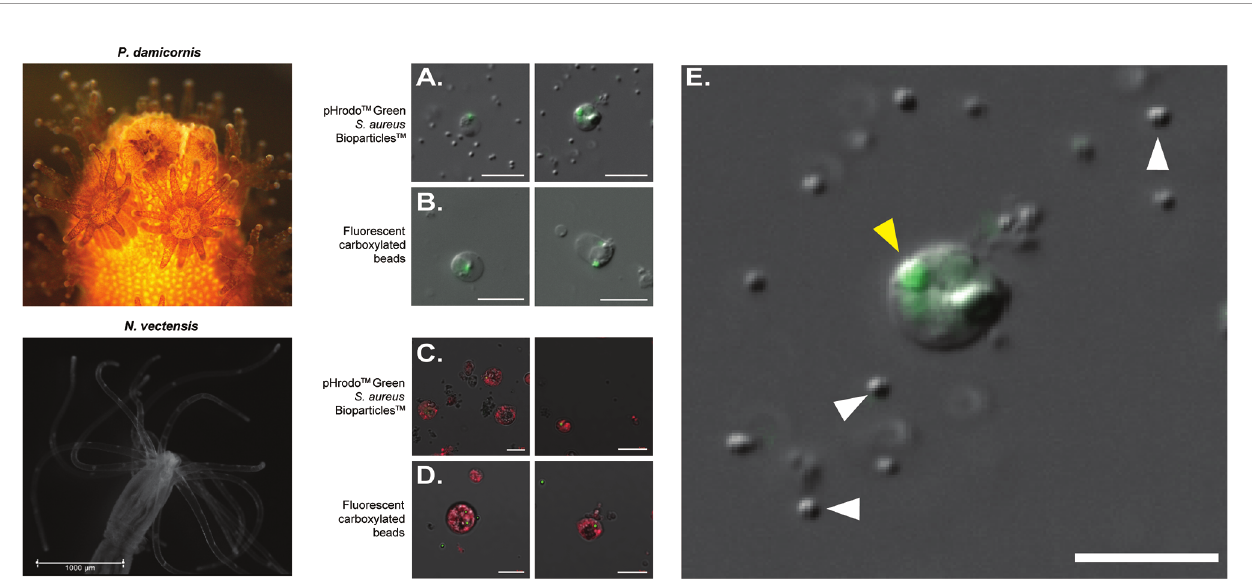
FIGURE 1 | FACS-isolated cells of Pocillopora damicornis and Nematostella vectensis positive for phagocytosis. (A – E) Images of sorted cells positive for S. aureus and bead assays. (A) Images of sorted cells from P. damicornis challenged with inactive pHrodo ™ S. aureus particles, with the center host cells having internalized, pH-activated bacteria. (B) Images of sorted cells from P. damicornis challenged with fl uorescent carboxylated beads, with the center host cells having internalized beads. (C) Images of sorted cells from N. vectensis challenged with inactive pHrodo ™ S. aureus particles, with the CellTrace-stained animal cells having internalized, pH-activated bacteria. (D) Images of sorted cells from N. vectensis challenged with fl uorescent carboxylated beads, with the CellTrace-stained cells having internalized beads. (E) Enlarged version of right image in (A) , a P. damicornis cell challenged with S. aureus . Yellow arrow shows an internalized, pH-activated S. aureus particle that fl uoresces bright green at a low pH. White arrows indicate the cocci bacterial particles. S. aureus particles are fl uorescent after the fusion of the bacteria with the lysolitic vesicle, which leads to lowered pH. This is not seen in the free bacteria that are not internalized by the cells and can be seen only with DIC. All P. damicornis pictures were taken on a ZEISS Axio Imager.Z2 microscope with a magni fi cation of 40X using a combination of DIC and 470nm LED with ZEISS 38HE fi lter set. All N. vectensis pictures were taken on ZEISS LSM900 confocal microscope with a magni fi cation of 40X using a combination of PMT, green and far- red fi lters. White scale bars represent 10 m